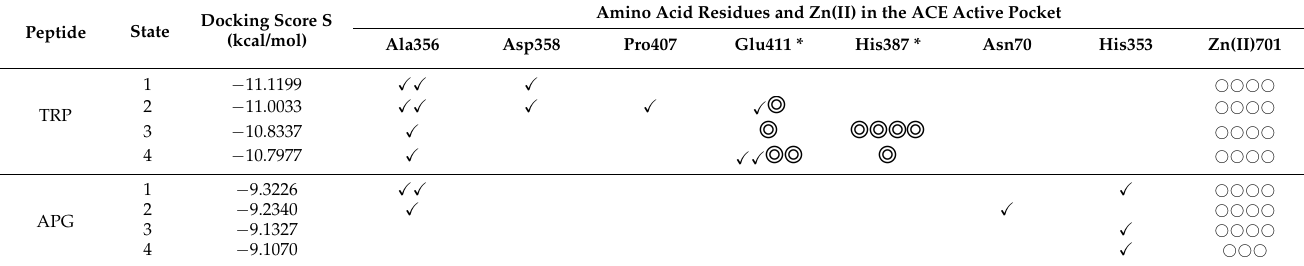
Table 4. Intermolecular interaction of TRP or APG with ACE (PDB ID code: 1O8A) in the states of four lower docking score S levels.